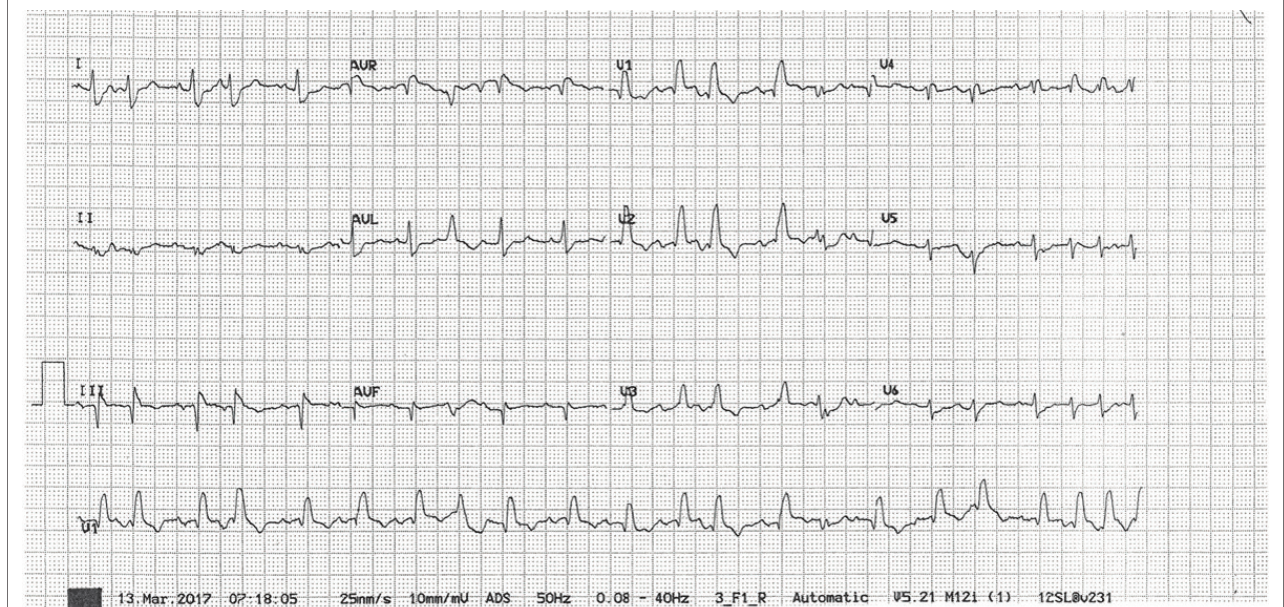
FIGURE 1: Electrocardiogram on presentation of cardiac tamponade.